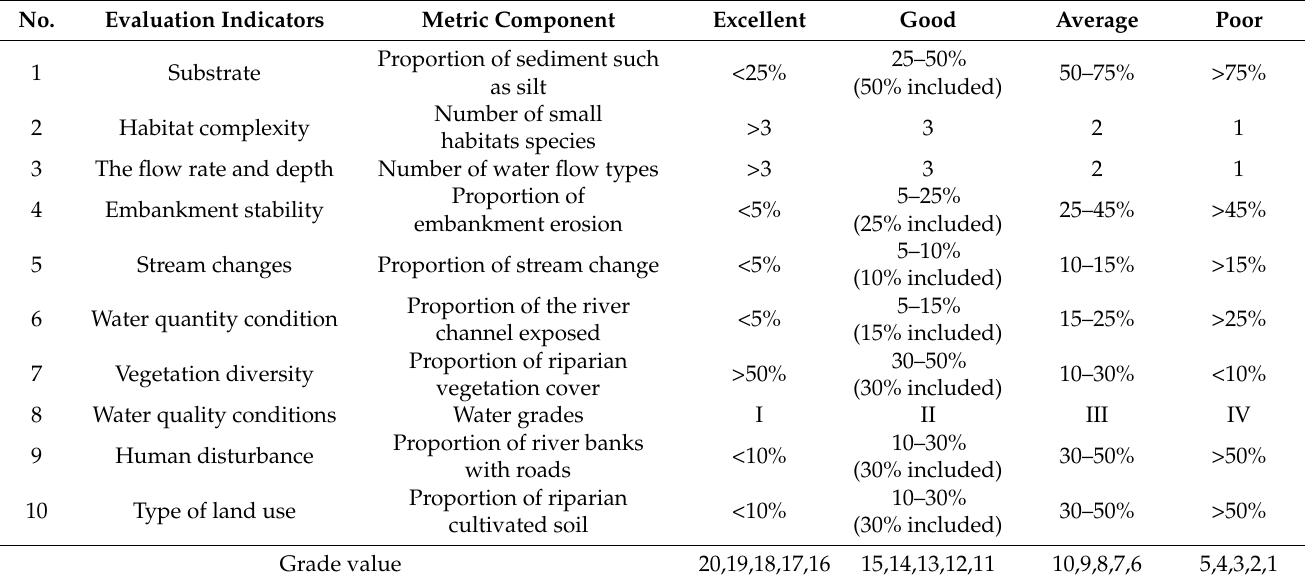
Table 1. Habitat evaluation indicators and evaluation criteria for the lower Yangtze